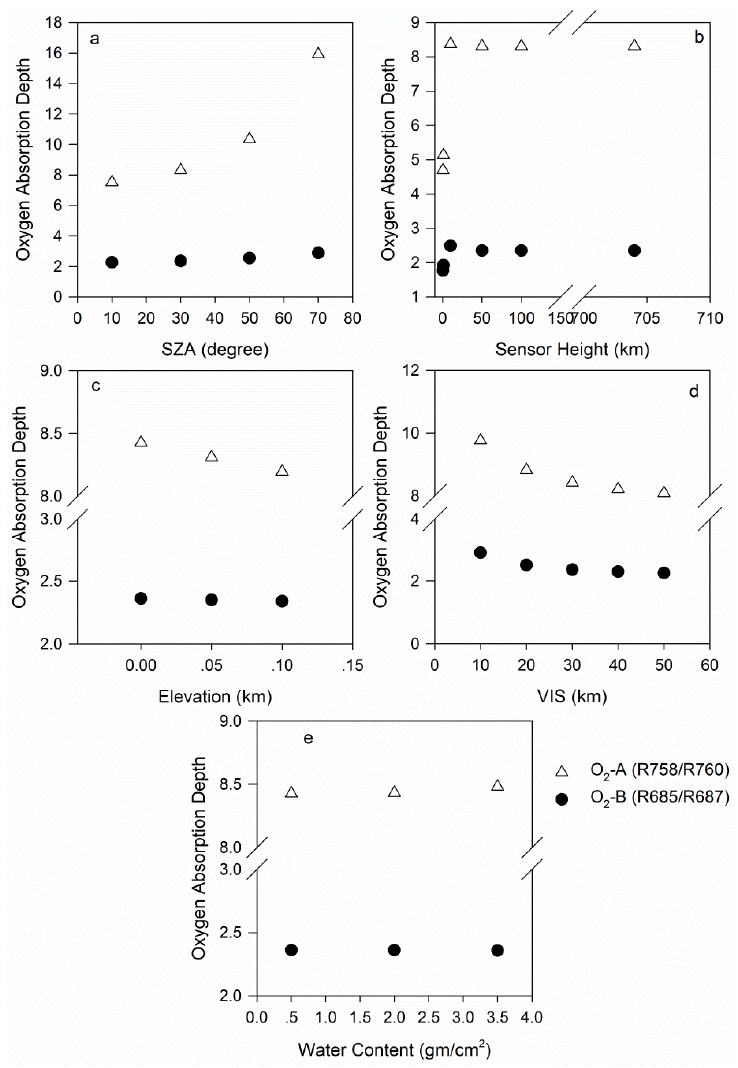
Figure 4. Atmospheric effects on the oxygen absorption band depth. Table 5. Sensitivity analysis. The depth variation is the maximum variation and is calculated as the variation value divided by the base value.